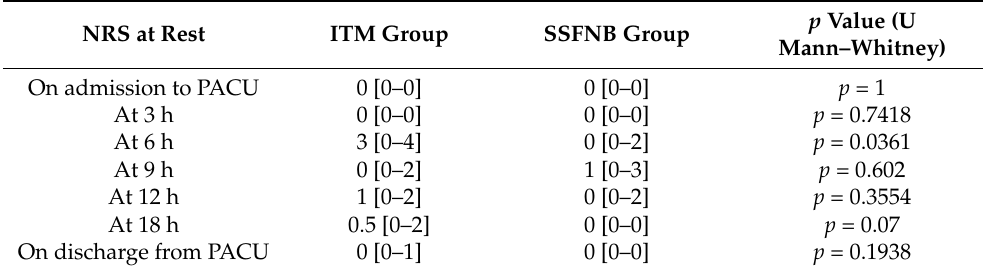
Table 3. Postoperative pain levels at rest.